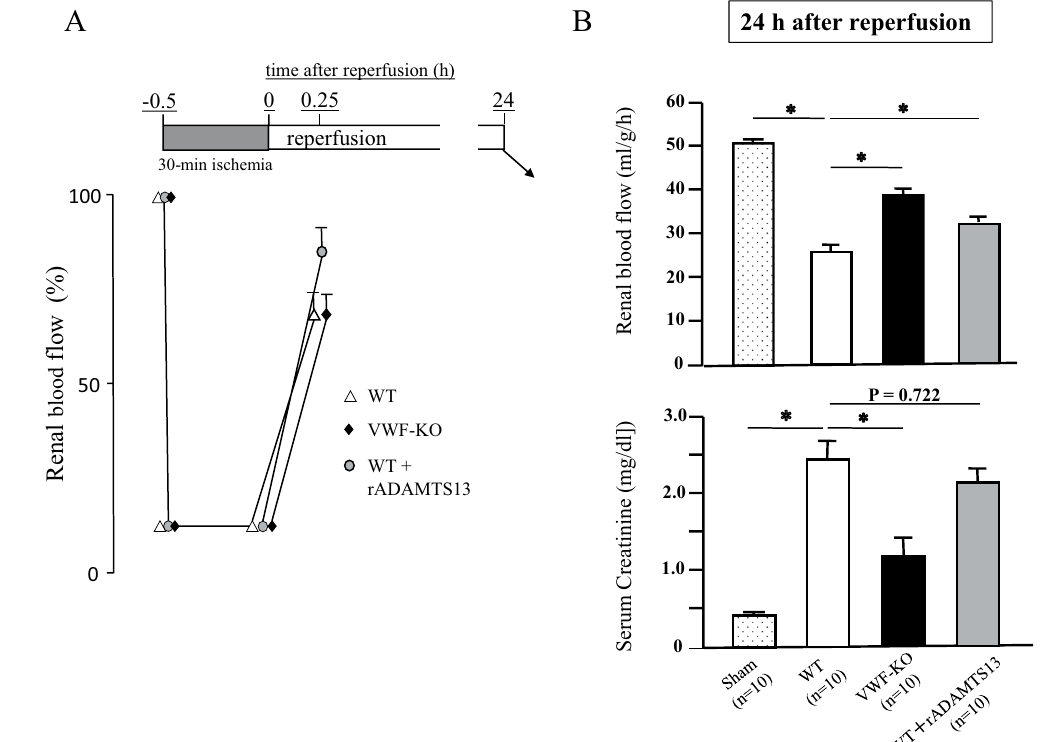
Figure 1. Effects of gene deletion of VWF or rADAMTS13 on RBF and serum creatinine in mice with I/R kidney injury. I/R injury was induced in the left kidneys of WT (n = 10) and VWF-KO mice (n = 10) (see the upper horizontal bar representing the I/R protocol); the right kidneys had been surgically removed 1 week prior to the I/R experiment. In another group of WT mice (n = 10), rADAMTS13 (10 μ g/mouse) was injected intravenously 15 min before the I/R operation. ( A ) RBF, measured at 15 min after reperfusion by Laser Doppler flowmetry, is expressed as the percentage of the pre-ischemic value (mean ± SEM). During the ischemic phase, RBF is maintained at around 10% of the pre-ischemic value for 30 min. Then, the RBF in all mice tested are restored to approximately 65–85% of the pre-ischemic value at 15 min after reperfusion. ( B ) Upper panel; Bars indicate the mean actual RBF units ± SEM (ml/g/h, n = 10, each group; plus Sham operation as a negative control, n = 10) at 24 h after reperfusion. The RBF in VWF-KO mice is significantly ( * p < 0.05) greater than that in WT mice 24 h after reperfusion. Note also that rADAMTS13 injection significantly ( * p < 0.05) improved RBF in WT mice at 24 h after reperfusion. Lower panel; Bars indicate the mean ± SEM of serum creatinine values at 24 h after reperfusion. Consistent with the RBF data, the serum creatinine value in VWF-KO mice is significantly ( * p < 0.05) lower than that in WT mice. The RBF and serum creatinine values demonstrated that kidney damages during reperfusion was less extensive in VWF-KO mice than in WT controls, and that the administration of rADAMTS13 significantly improved kidney damages in WT